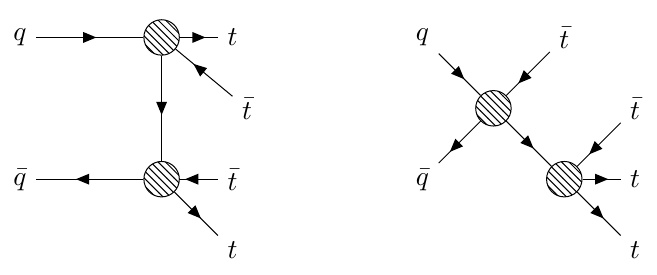
Figure 21 . Representative diagrams of four-top production with two EFT insertions represented by the shaded